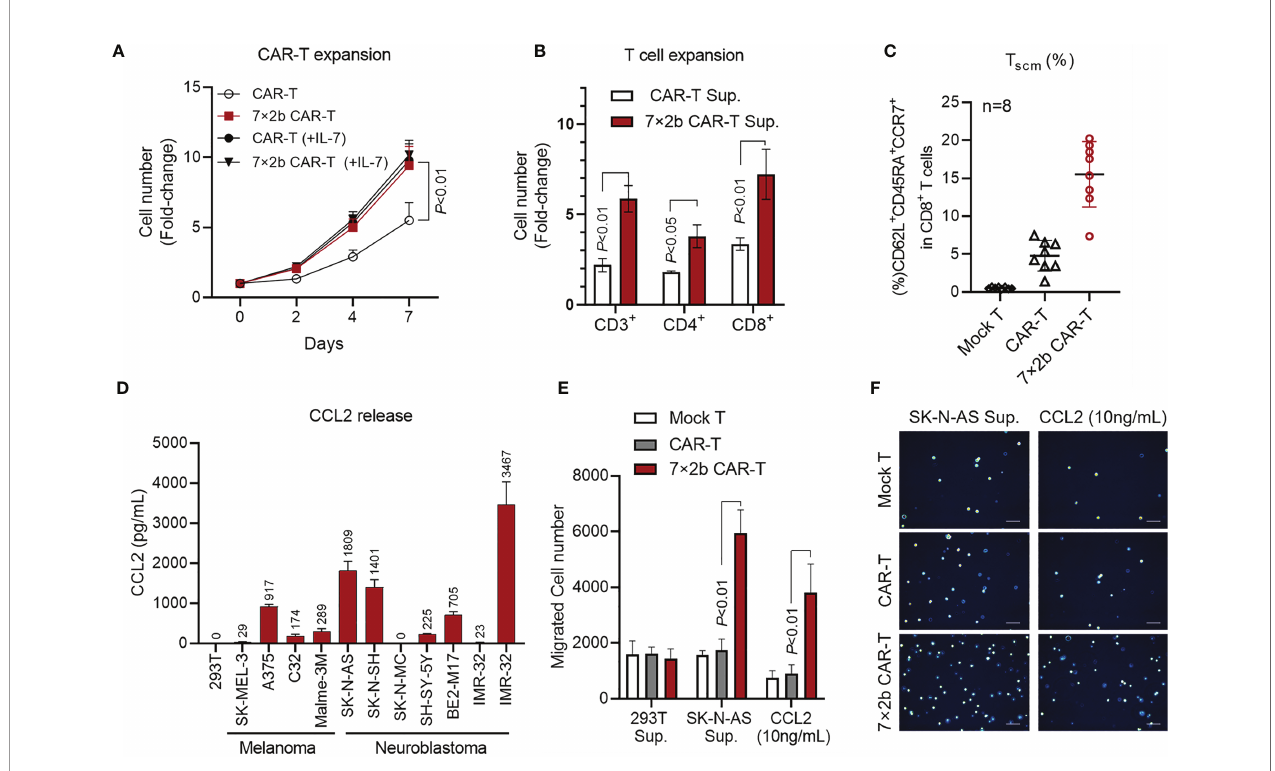
FIGURE 3 | The IL-7 and CCR2b co-expression enhanced 7×2b CAR-T cell survival and migration. (A) The proliferation ability of 7×2b CAR-T cells. We cultured one million conventional CAR-T and 7×2b cells (all with IL-2), and the cell number was calculated in the presence or absence of IL-7. (B) The effect of 7×2b CAR-T cell supernatant on T cell ampli fi cation. Supernatants of CAR-T were collected and mixed with H3 medium supplemented with 2% of autologous serum and 300 U/mL of IL- 2 at a 1:1 ratio, which was then used to culture 1×106 CD3+ T cells for 7 days to detect the ampli fi cation ratio of CD3, CD4, and CD8 subsets. (C) The CAR-T cells were prepared independently 8 times, and the TSCM subset proportions were analyzed. (D) The CCL2 level in the supernatant was detected by ELISA after 48 h of culture of 5×106 tumor cells. (E) The migration ability of CAR-T cells induced by HEK293T cells, SK-NS-AS cells, and CCL2 (100 ng/mL). (F) Representation of the lower Transwell compartment, showing T cells in each lower compartment. N = 3, p < 0.05, p <